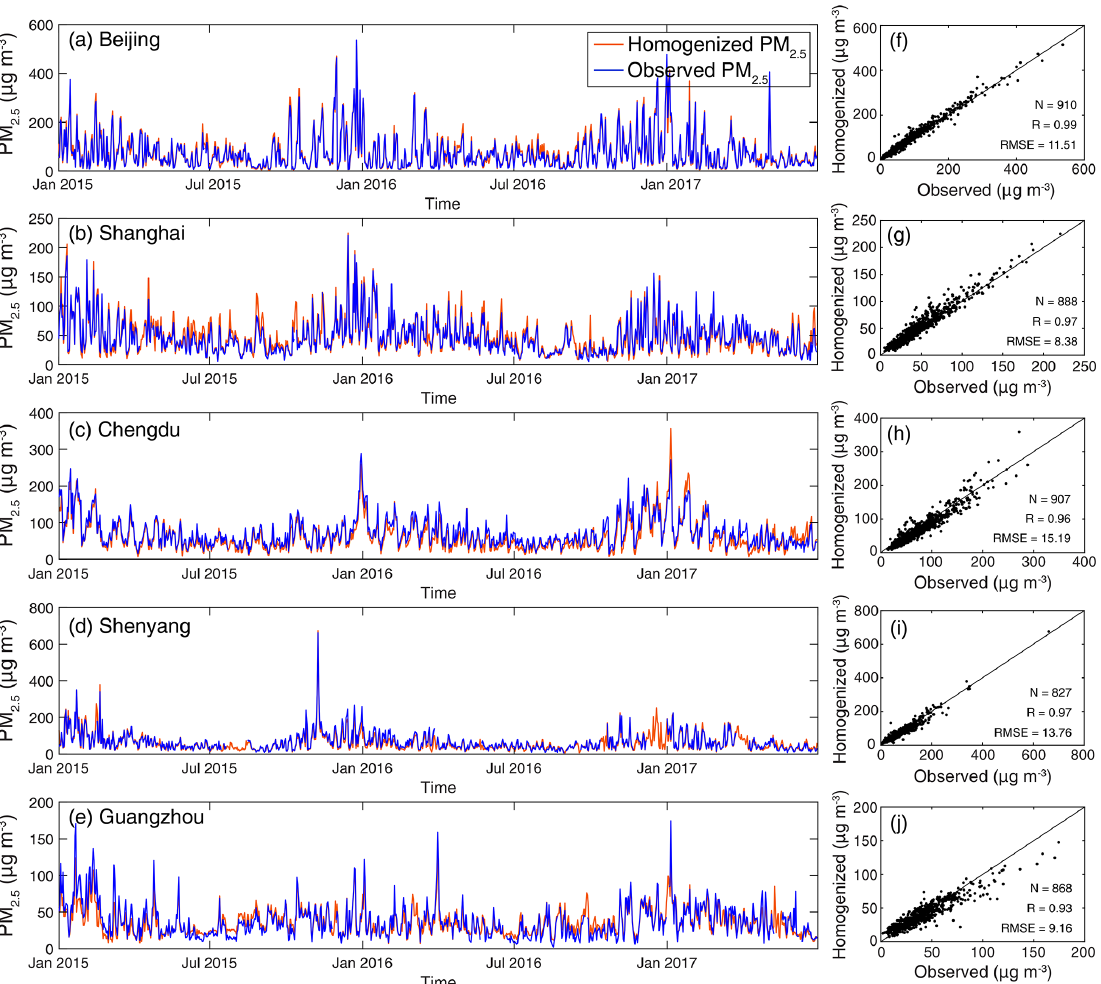
Figure 8. Comparisons of the homogenized PM 2 . 5 concentration (red) against PM 2 . 5 observations (blue) measured at five consulates of the United States in China from January 2015 to June 2017. (a–e) Temporal variations of daily PM 2 . 5 concentration and (f–j) the associated scatter plots. Table 1. Regional mean trend for PM 2 . 5 concentrations over eight major ROIs in China during 2015–2019 before and after the data homog- enization. Uncertainties in trend estimations were characterized at the 95% confidence interval. Locations of these ROIs can be found in Fig. S4.